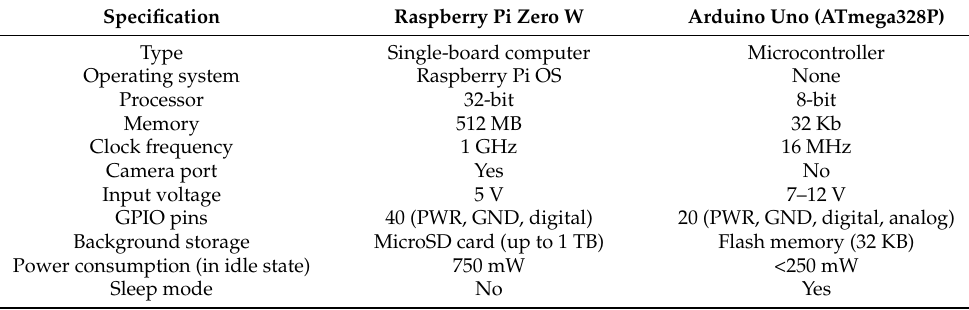
Table 1. Comparison of the Raspberry Pi Zero and Arduino